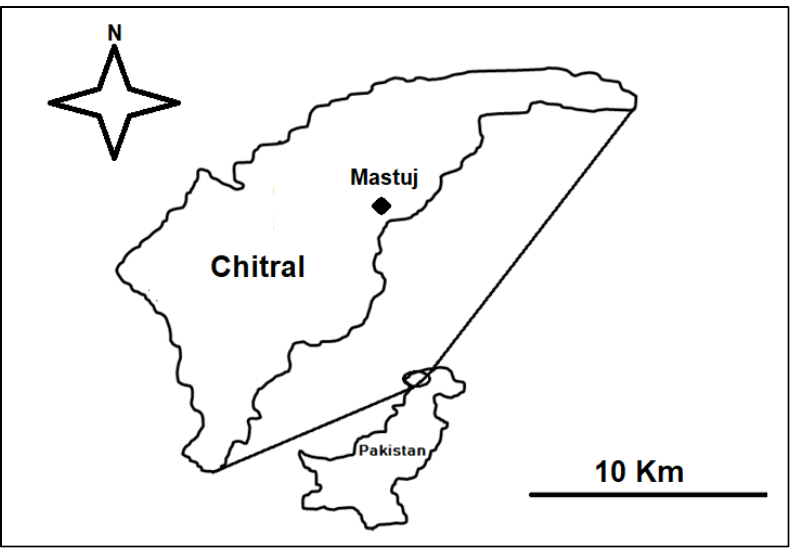
Figure 1. Location of the study area in Pakistan.